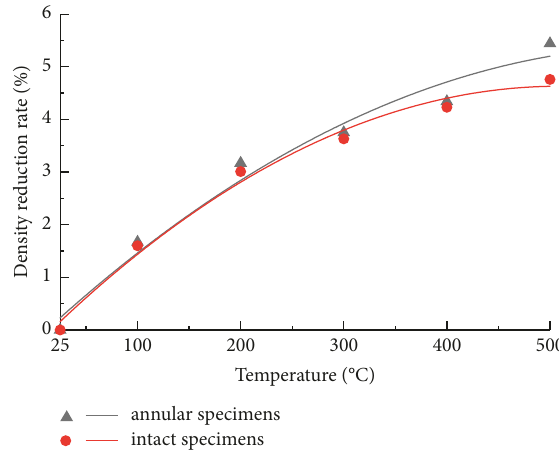
Figure 5: Density reduction rate of sandstone specimens after different